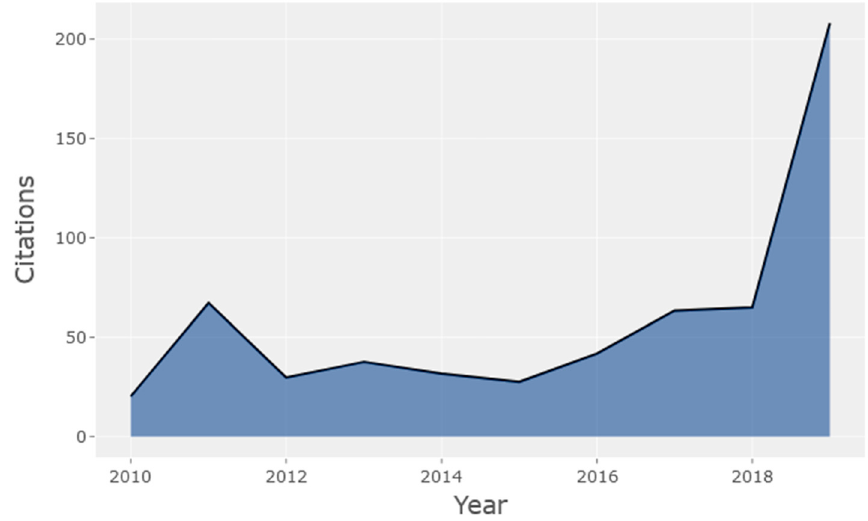
Figure 2. Average citations per year of HCPs in the mass cytometry research field (2010–2019).